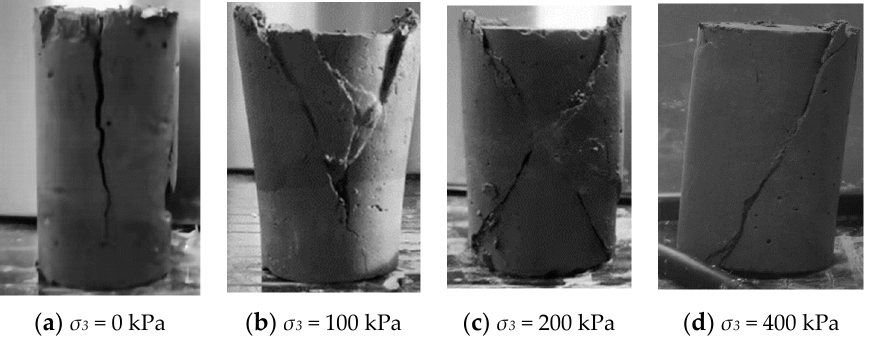
Figure 10. Photographs of cemented soil specimens after test. ( a ) Tension failure; ( b ) Tensile shear failure; ( c ) Conjugate shear failure; ( d ) Single shear failure.